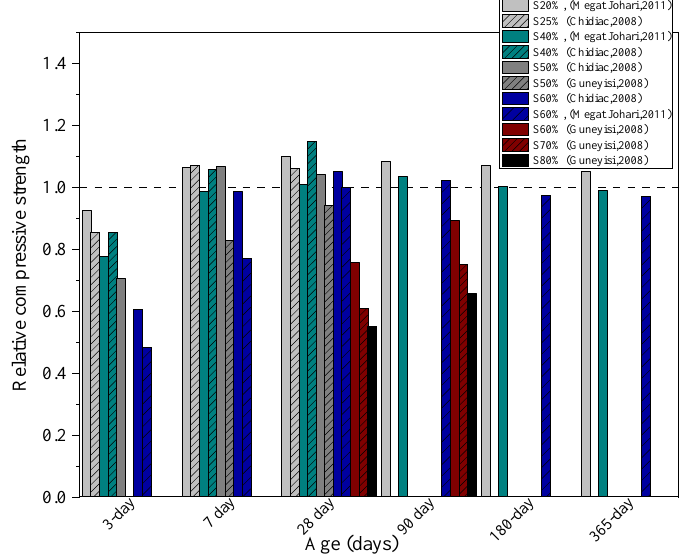
Figure 8. Relative compressive strength of concrete containing slag (S) at various curing ages [26,28,29].